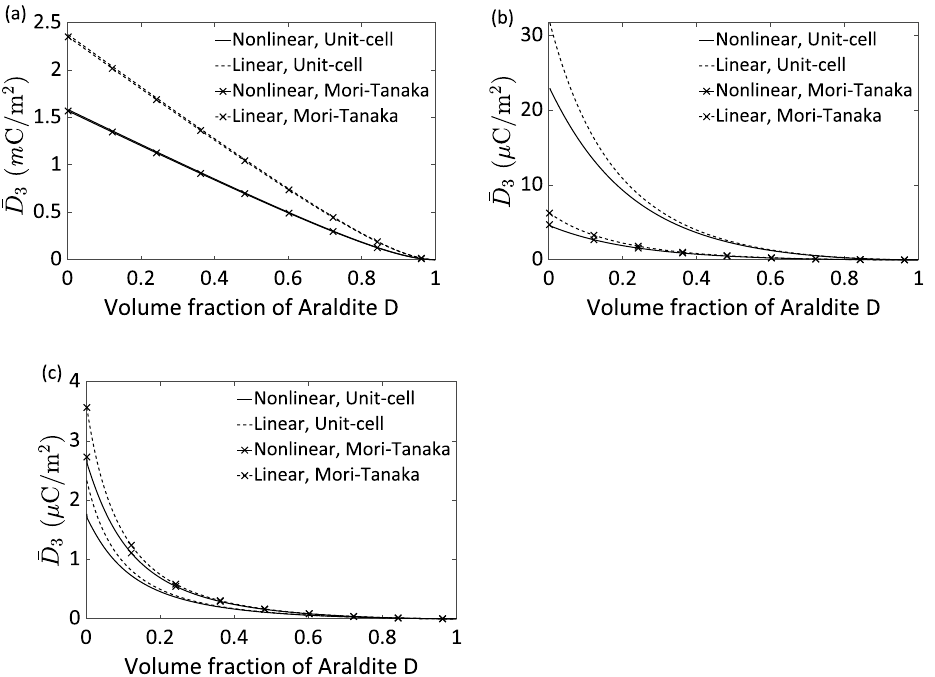
Figure 7. Effective electric displacement D 3 as a function of Araldite D volume fraction for a stress-free Terfenol-D/PZT G-1195/Araldite D composite subjected to a constant magnetic field H 3 = 100 k A/m having 1–3 ( a ), 0–3 ( b ), and 2–2 ( c ) connectivities, respectively. The ratio of the volume fraction of the Terfenol-D to the PZT G-1195 is kept as